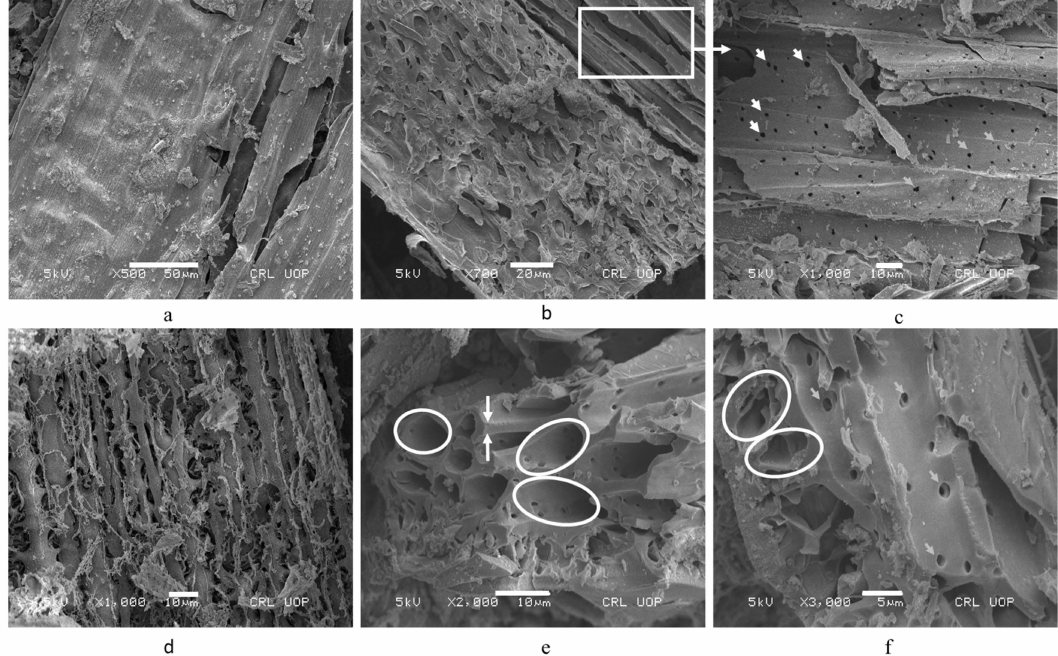
Figure 3. SEM of WSA at varying magnification levels, ( a – d ): The fibrous nature of WSA at the macroscopic scale has also been retained at the microscopic level; ( e , f ): WSA particles containing micro-perforations, micro-tubules’ of diameter between 0.25 to 2 µ m and 2 to 7 µ m,